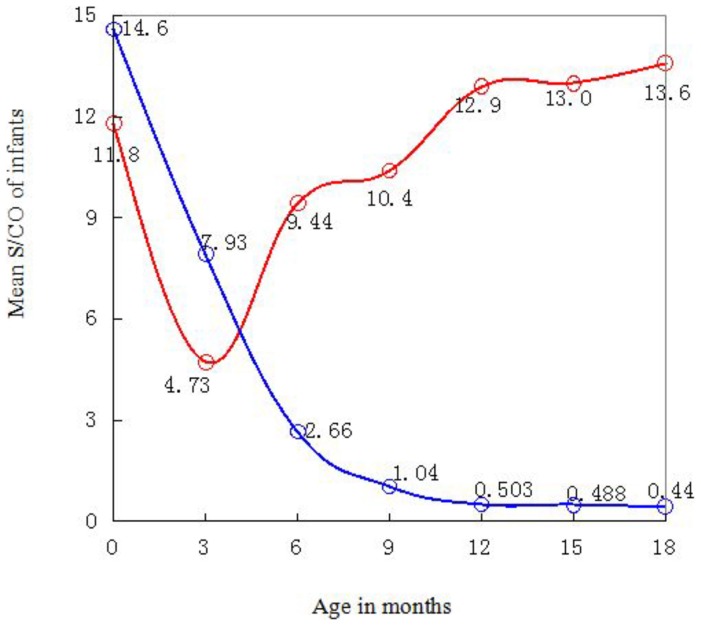
Mean anti-HIV S/CO values of infants.Red and blue lines indicate infected and uninfected infants, respectively. Calculations were based on 943 DBSs from 256 uninfected infants and 82 DBSs from 24 infected infants. At each month of age, sample sizes of infected babies were all ≥11 except at 9 months of age with 6 samples; sample sizes of uninfected babies were all ≥93.